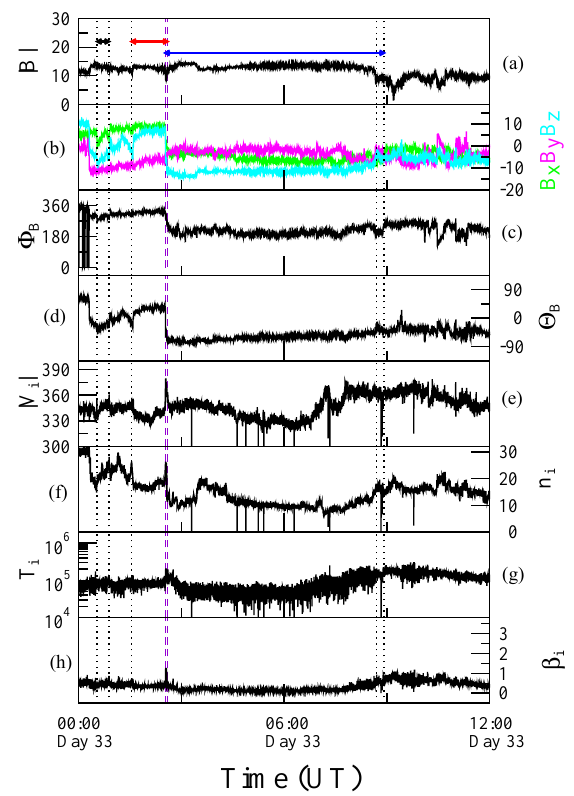
Figure 1. Cluster-1 magnetic field and plasma parameters from 00:00 to 12:00UT on 2 February 2002. From top to bottom: mod- ulus of magnetic field | B | (nT), three components of B (nT) in the GSE coordinates, azimuth angle (cid:56) B ( ◦ ), latitude angle (cid:50) ( ◦ ), modulus of ion bulk velocity | V i | (kms − 1 ), ion number density n i (cm − 3 ), ion temperature T i (eV) and ion plasma beta β i . Horizontal arrows indicate the interval of IMFR-1 (black), IMFR-2 (red) and IMFR-3 (blue). The front and rear boundary layers of each IMFR are indicated by the vertical dotted